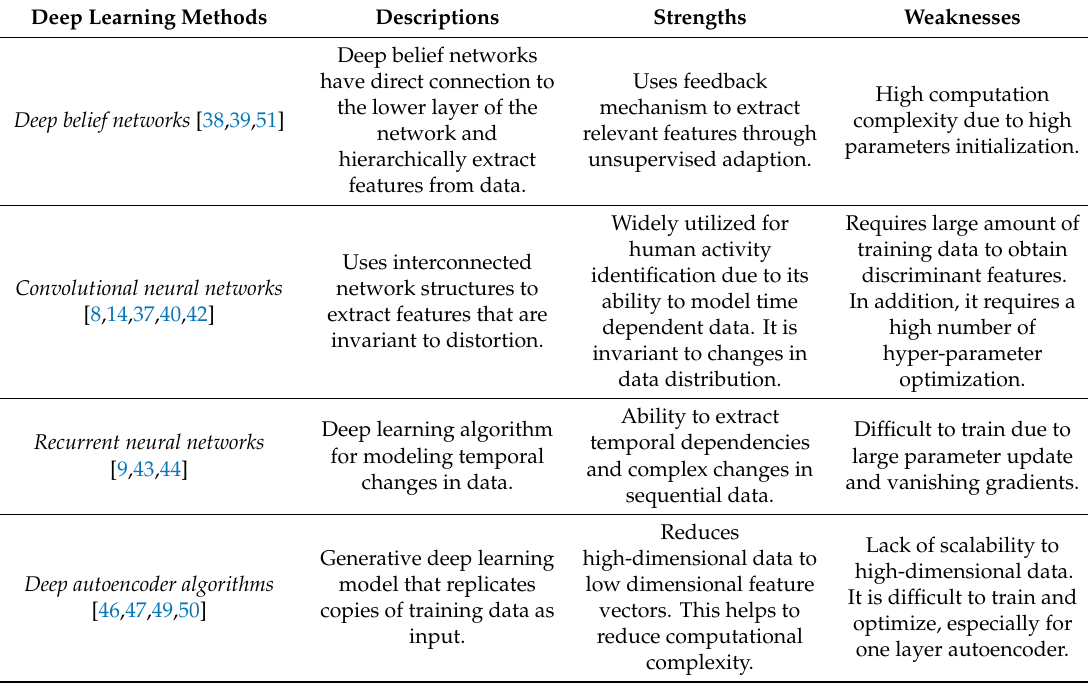
Table 1. Summary of various deep learning algorithms for human activity